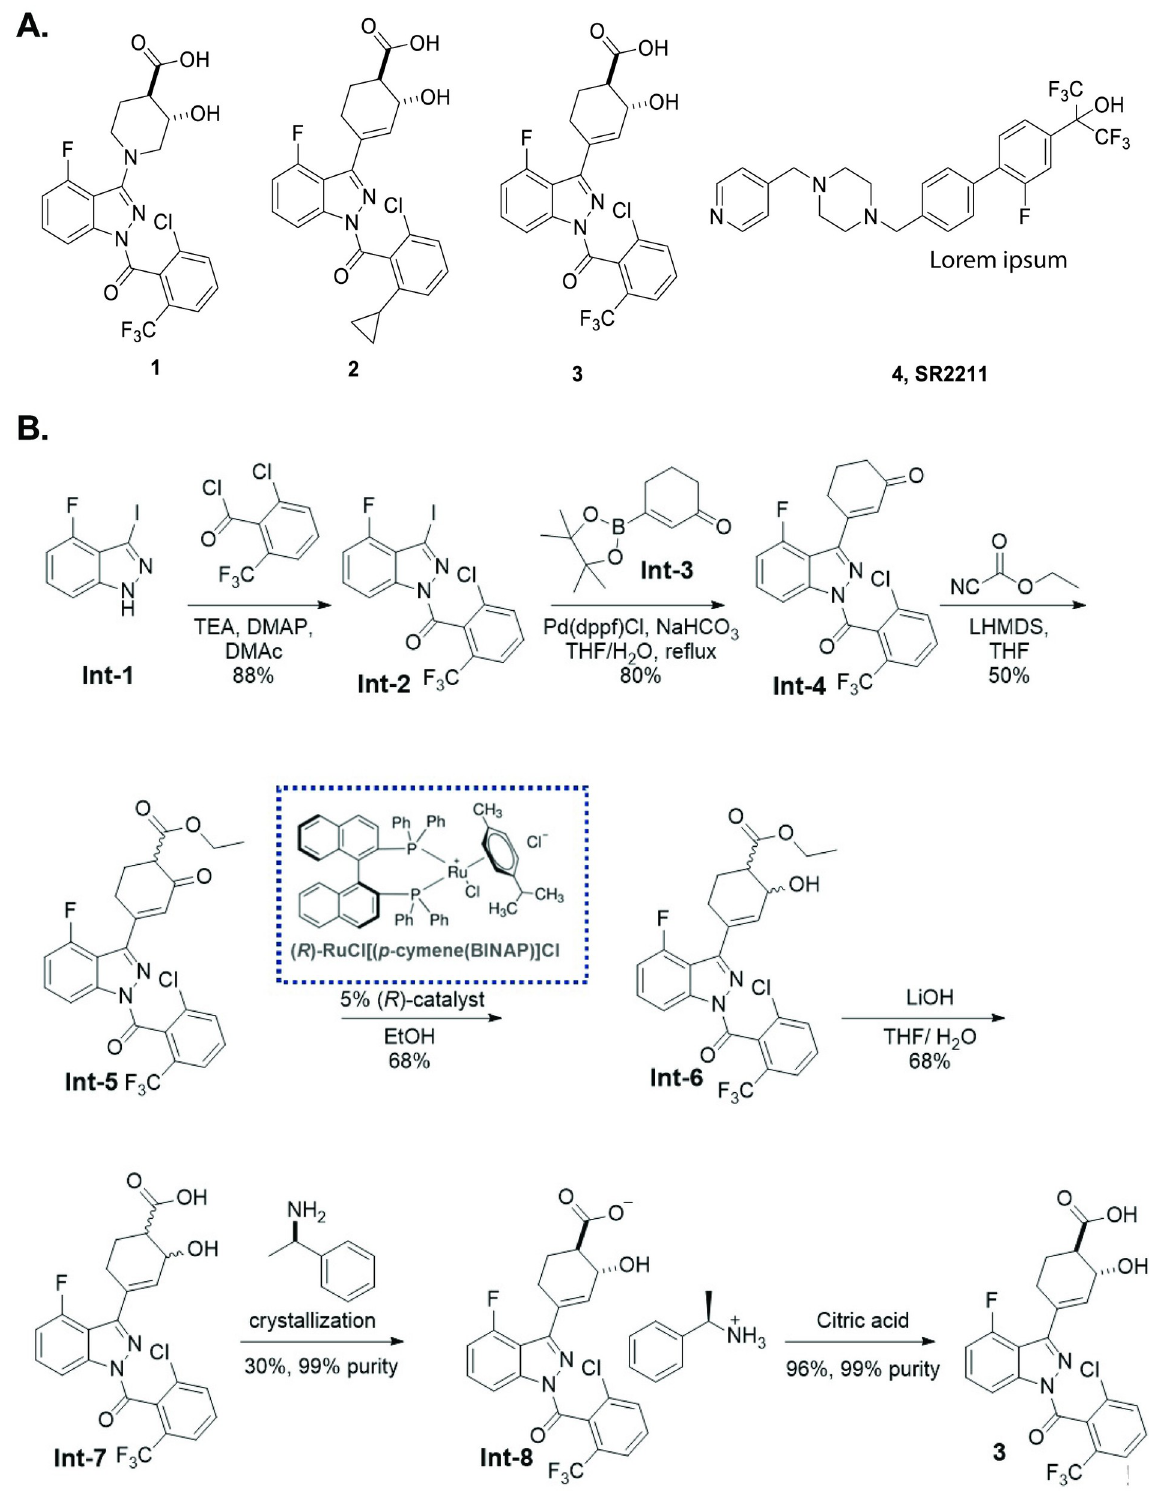
Fig 1. Representative ROR γ t inhibitors (Compounds 1–3) and inverse agonist, SR2211. Structures of Compounds 1–3 compared to inverse agonist, SR2211 (A) and chemical synthesis route for Compound 3 (B) .